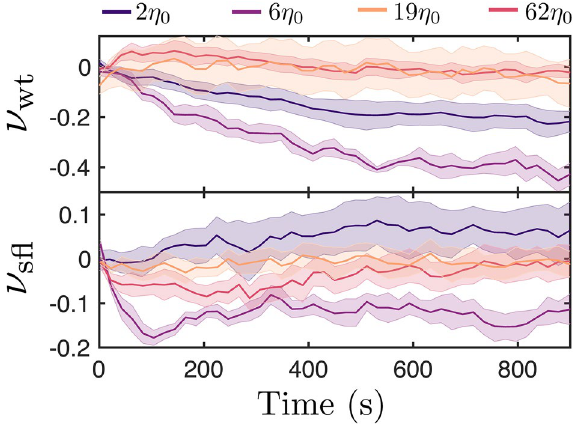
Figure 5. The time evolution of the normalised ratio ν for wt (top) and sfl (bottom) CR for different